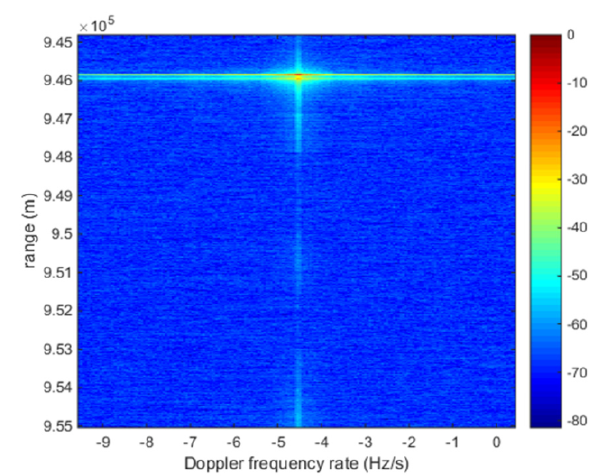
Figure 5. The multi-source fusion result with LEO-based satellite constellation.